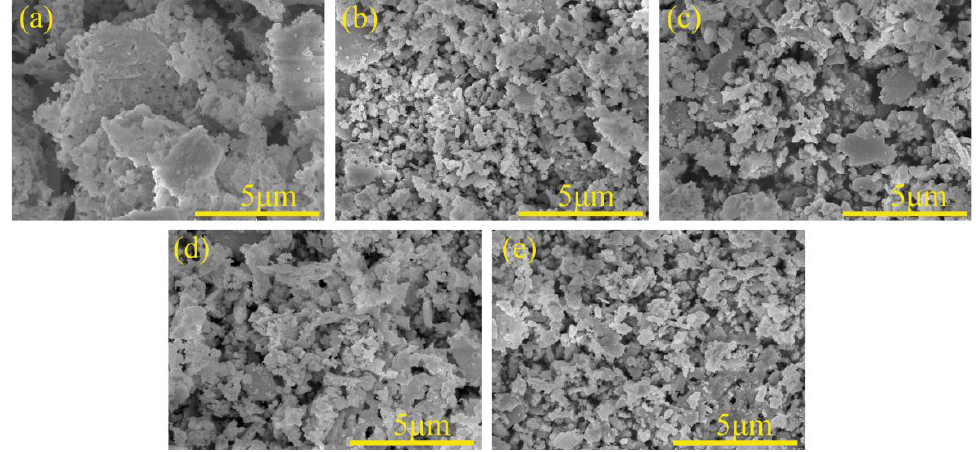
Figure 2. SEM images of PBCFC-0 ( a ), PBCFC-2 ( b ), PBCFC-4 ( c ), PBCFC-6 ( d ), and PBCFC-8 ( e ) samples.